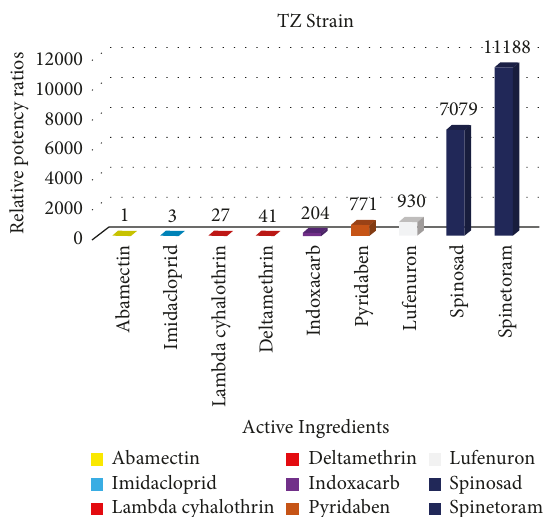
Figure 2: Relative potency ratios of different insecticides against fall armyworm in Kenya.